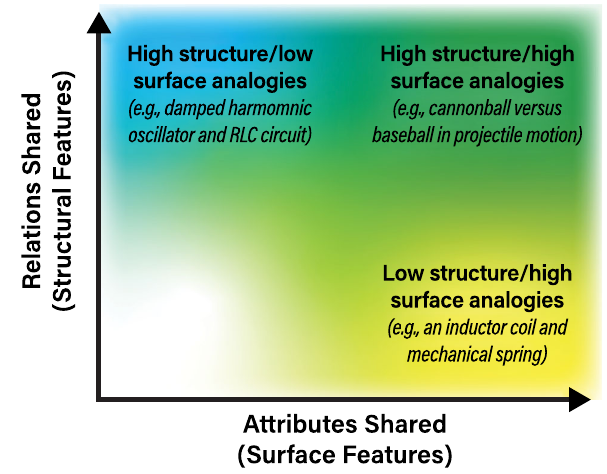
FIG. 1. A visual representation of the space of analogy types that we use to classify theorists ’ analogies, based on the extent to which structural (vertical axis) and surface (horizontal axis) are mapped from base to target. Colors demonstrate that this space is a spectrum rather than a set of distinct categories. Concept for figure adapted from Gentner and Markman